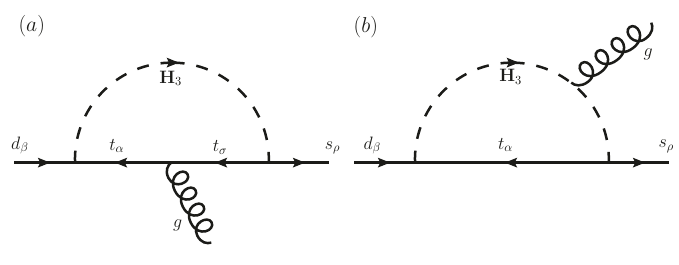
) transition mediated by color-triplet di- (cid:3)